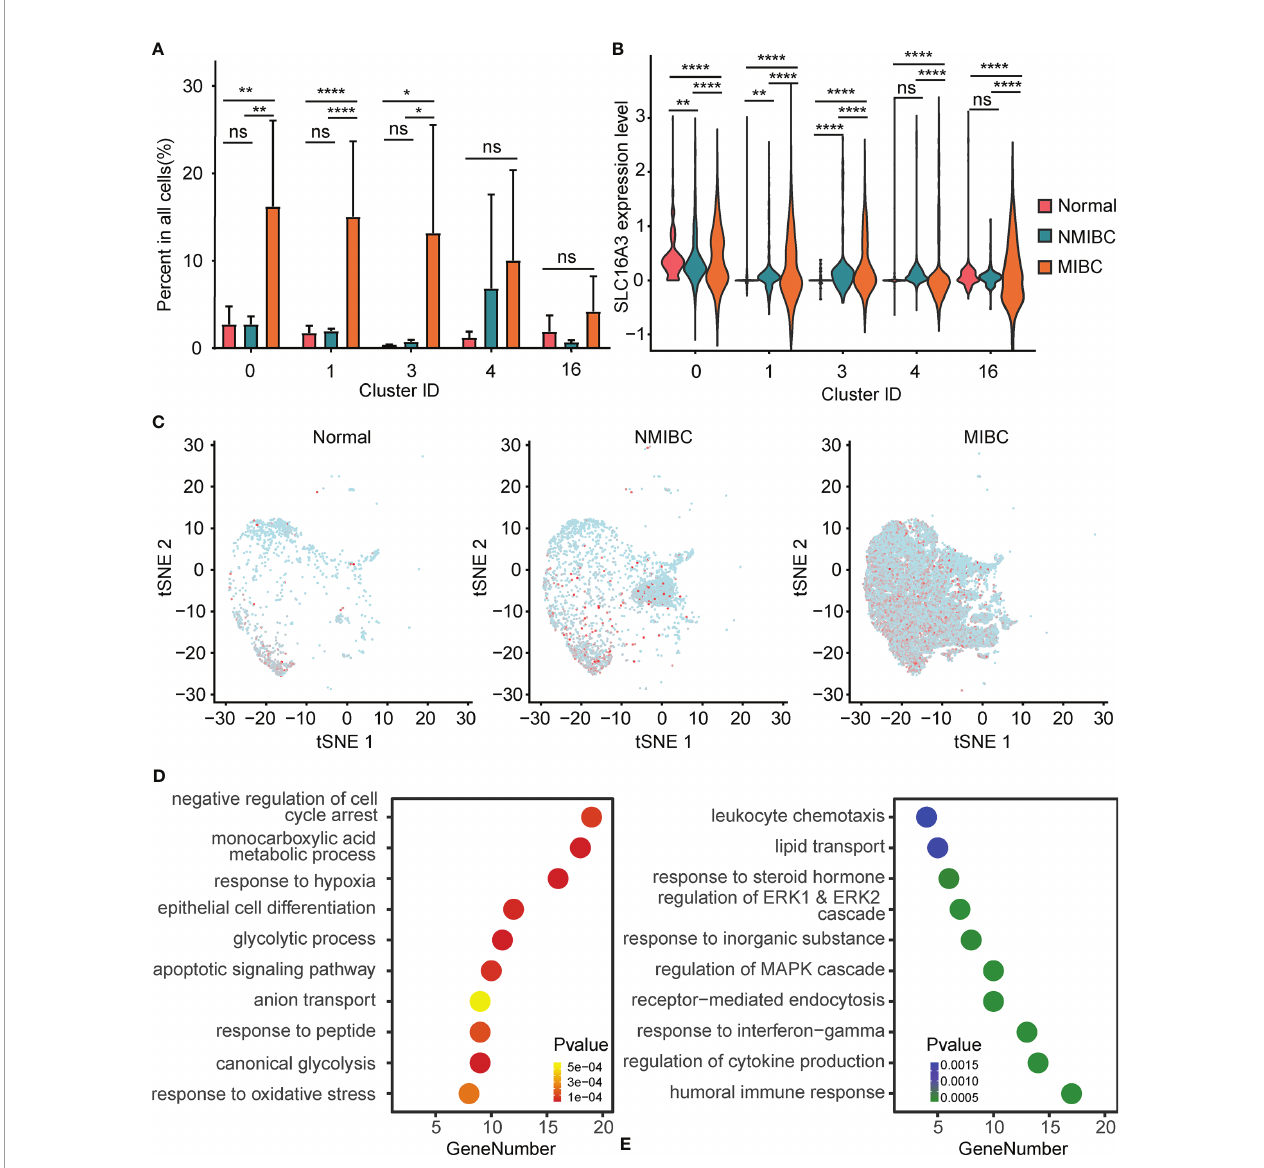
FIGURE 2 | Alteration of PFKFB3 in bladder cancer cells. (A) Histogram of the percentage of epithelial cell adhesion molecule (EPCAM)-positive epithelial cell clusters in non-muscle invasive bladder cancer (NMIBC), MIBC, and the normal bladder mucosa. NS, not signi fi cant; *p < 0.05 **p < 0.01; ****p < 0.0001. (B) Violin plot of the expression of SLC16A3 mRNA in epithelial cell clusters of NMIBC, MIBC, and the normal bladder mucosa. NS, not signi fi cant; **p < 0.01; ****p < 0.0001. (C) T-SNE plot of the expression of SLC16A3 in epithelial cells in NMIBC, MIBC, and normal bladder mucosa. Red points represent cells with positive PFKFB3 expression, and gray points represent cells with no PFKFB3 expression. (D) Gene set enrichment analysis of the upregulated differentially expressed genes (DEGs) in SLC16A3-positive epithelial cells. The y-axis shows signi fi cantly enriched Gene Ontology (GO) terms, and the x-axis shows the number of DEGs enriched in a GO term. (E) Gene set enrichment analysis of the downregulated DEGs in SLC16A3-positive epithelial